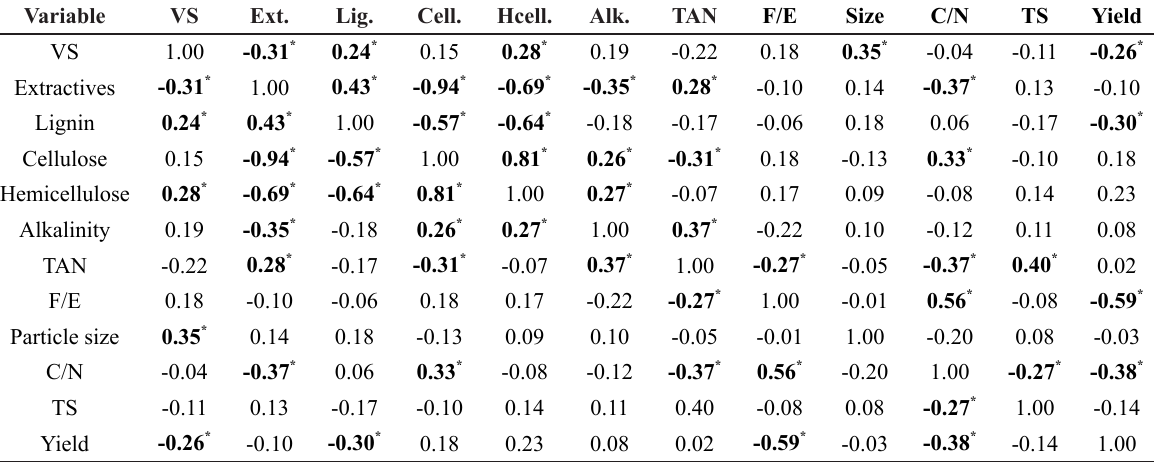
Correlation matrix for regression